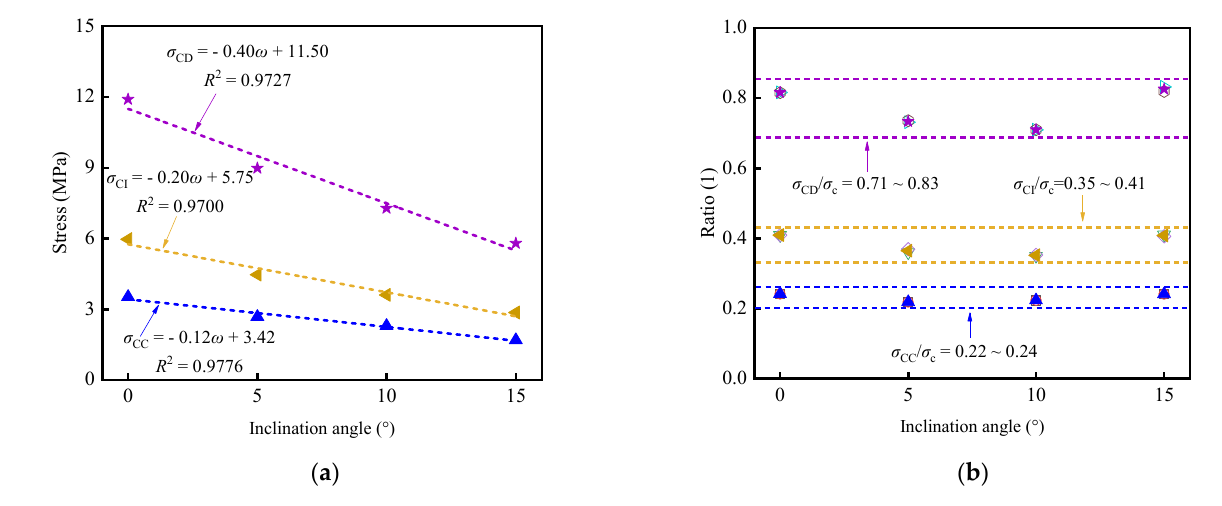
Figure 14. The average crack CC threshold, CI threshold, and CD threshold when the moisture content was 7.55%: ( a ) the CC threshold, CI threshold, and CD threshold changed with the inclination angle; ( b ) the ratio of the CC threshold, CI threshold, and CD threshold to σ c varied with the inclination angle. Table 1. Values of σ CC , σ CI , and σ CD at various inclination angles for ω = 7.55%.